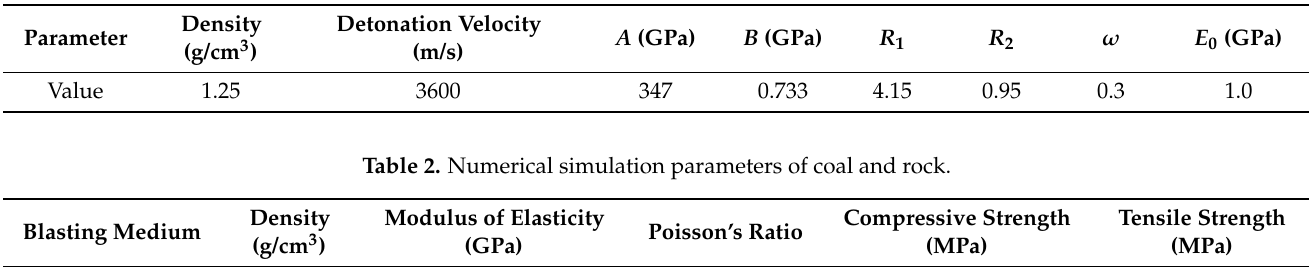
Table 1. Parameter setting of explosive in the numerical model.